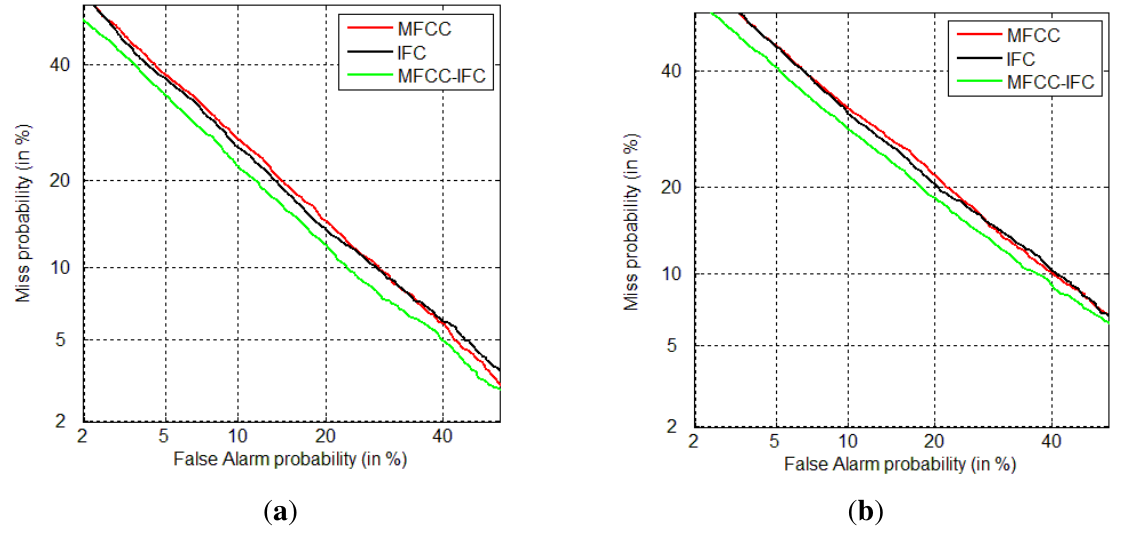
Figure 8. DET curves in the match case ( a ) and mismatch case ( b ).